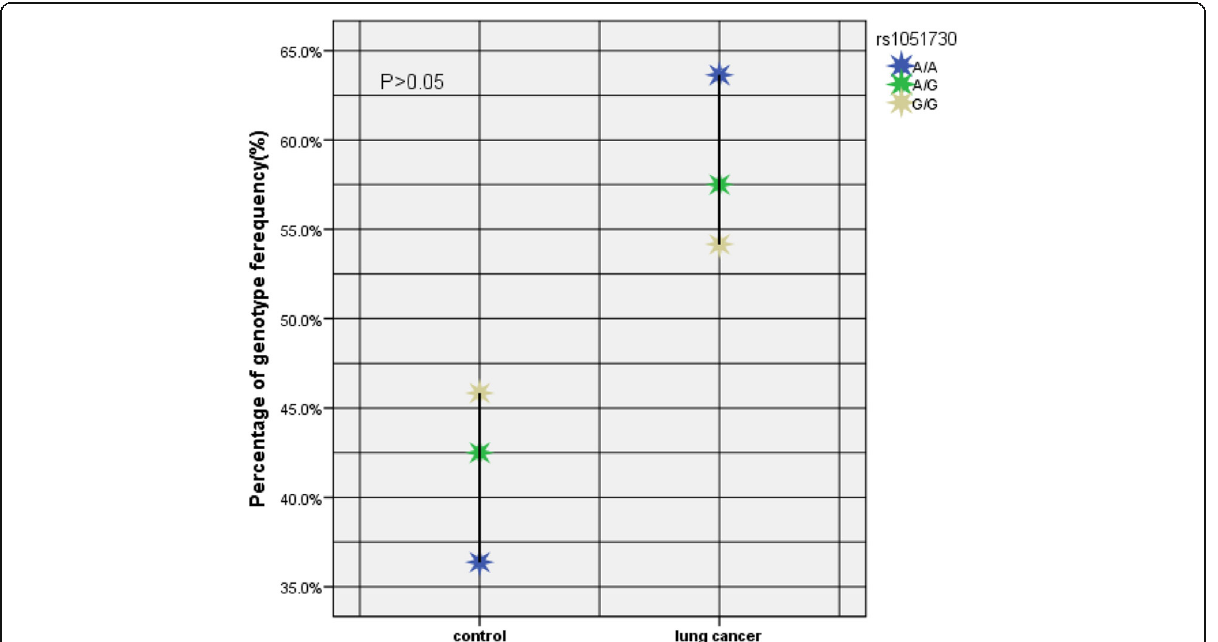
Fig. 1 Percentage of rs1051730 genotypes frequency in lung cancer patients and controls